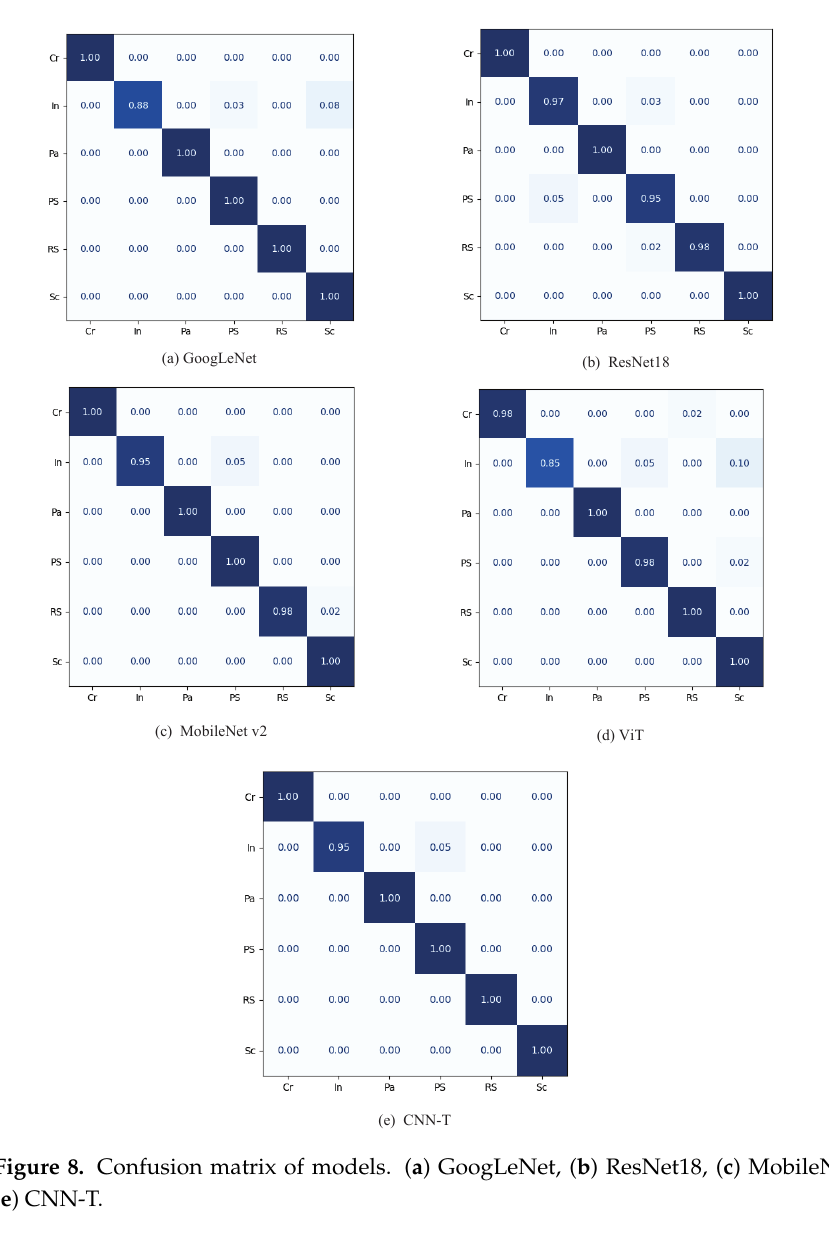
Figure 8. Confusion matrix of models. ( a ) GoogLeNet, ( b ) ResNet18, ( c ) MobileNet v2, ( d ) ViT, ( e ) CNN-T.